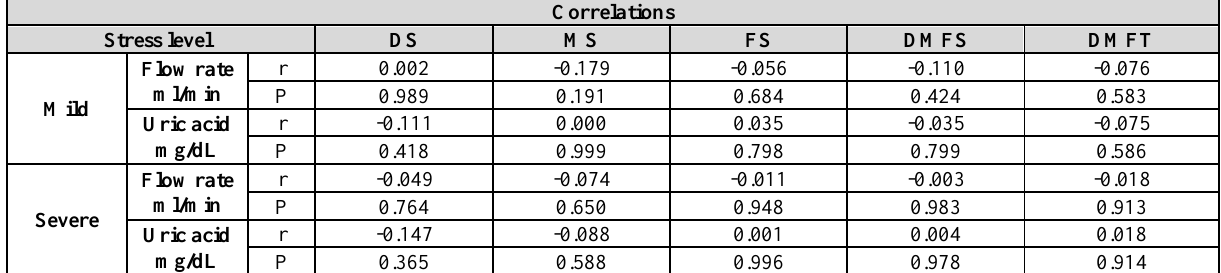
Table 4: Correlation coefficient of caries experience (DMFT, DMFS and its components DS, MS and FS) with salivary physicochemical characteristics according to dental environment stress